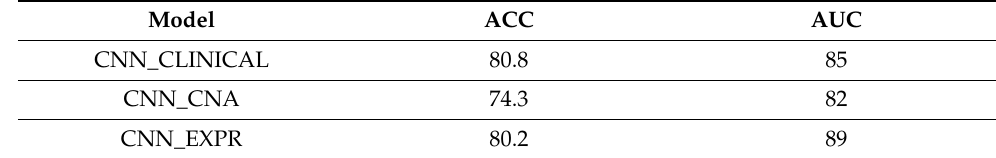
Table 9. Comparison of ACC and AUC between trained CNN models.